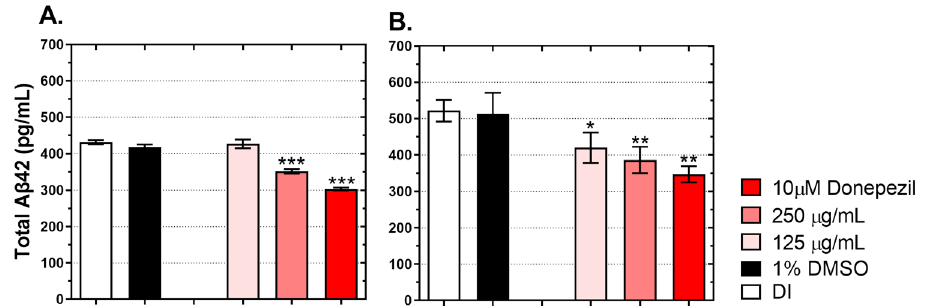
Figure 3. Effect of the ethanolic extract of D. esculentum on Aβ42 accumulation in Drosophila models as ( A ) flies expressing Aβ42 (chr.2) and ( B ) flies expressing Aβ42 (chr.3). AD-free flies (elav-Gal4) were cultured on a normal medium, while AD flies (Aβ42) were cultured on a medium containing deionized water (DI), 1% DMSO, 125 µg/mL and 250 µg/mL of D. esculentum and 10 µM donepezil for 28 days and then assayed for Aβ42 levels. Values are mean ± SD of three assays and statistical significance was analyzed against AD flies (DI) by one-way ANOVA followed by Tukey’s test. *, p < 0.05; **, p < 0.01; ***, p <